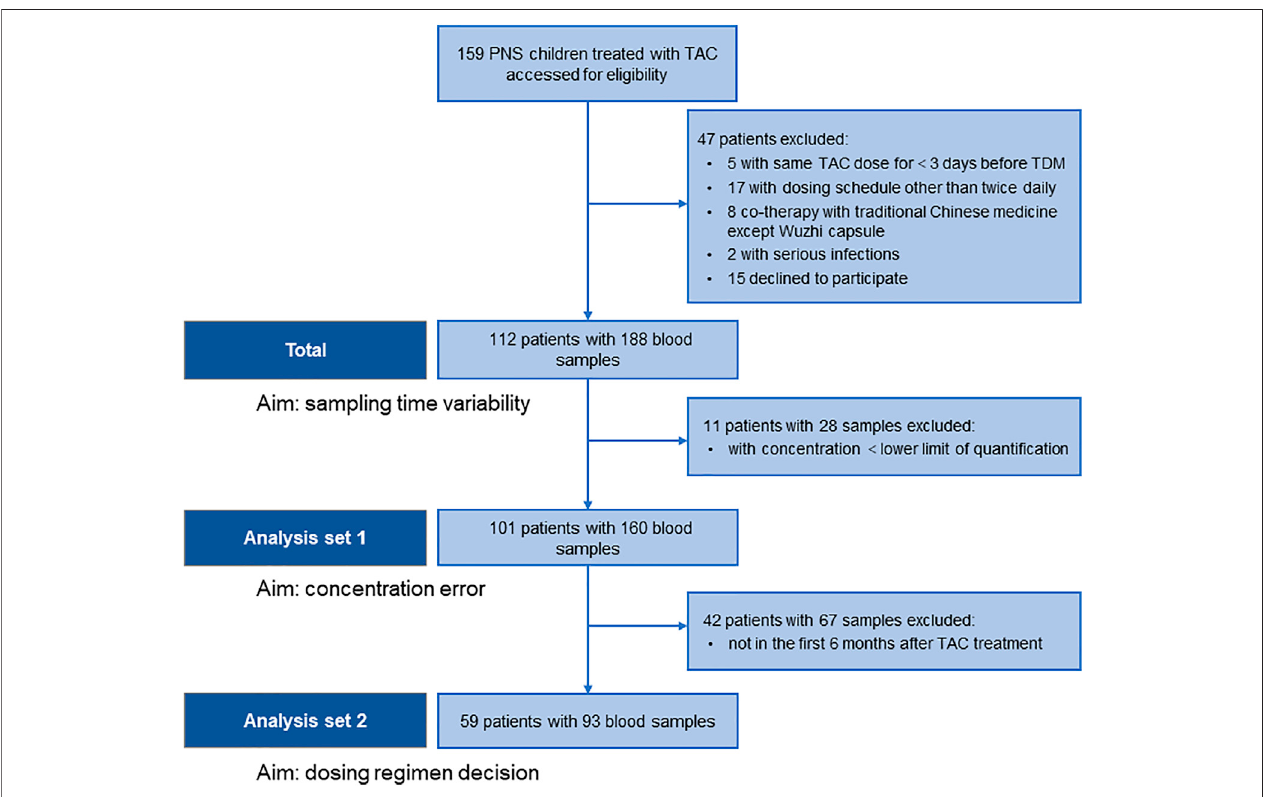
FIGURE 1 | Flow chart of patient enrollment and data analyses.